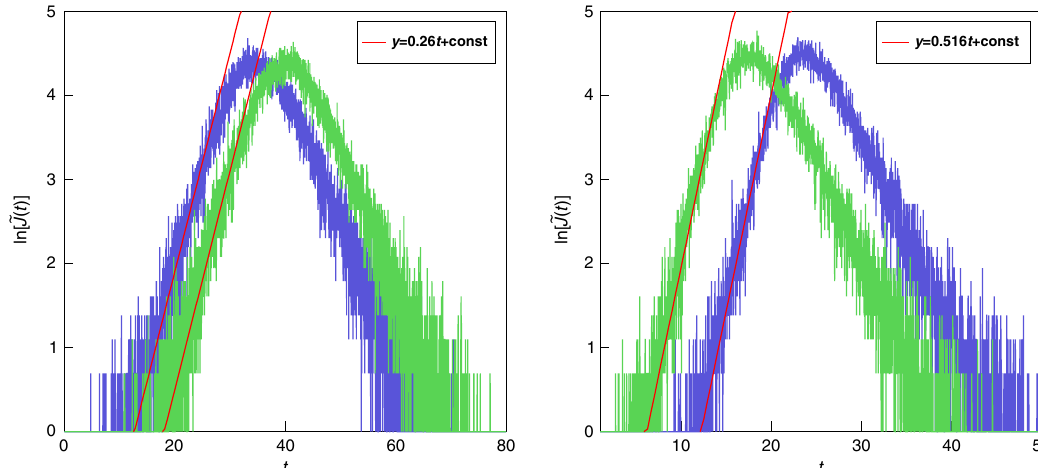
ln~ J ð t Þ for a binomial network with z 1 ¼ 5 (left panel) and for an ~ J ð t Þ(cid:3) in the exponential